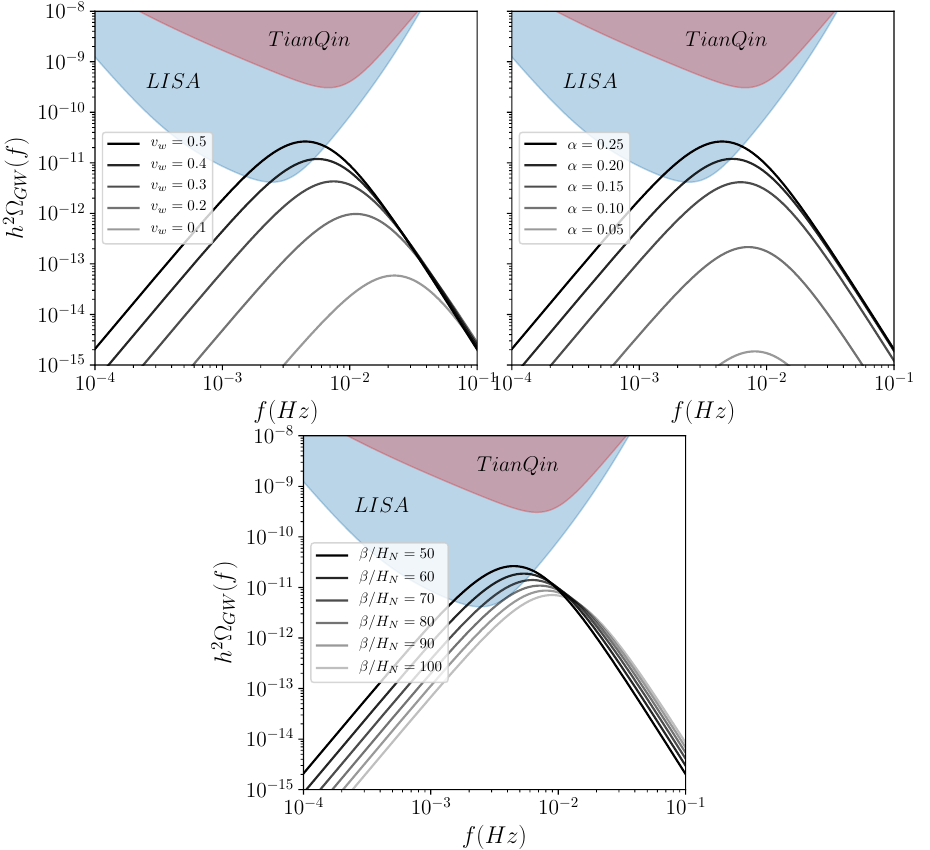
Figure 10 . Power spectra for varying v w , α , and β/H N respectively. The baseline takes values g ∗ = 100 , α = 0 . 25 , ∂p/∂e = α , β/H N = 50 , v w = 0 . 5 , and T N = 500 GeV, and is depicted as the darkest line on every